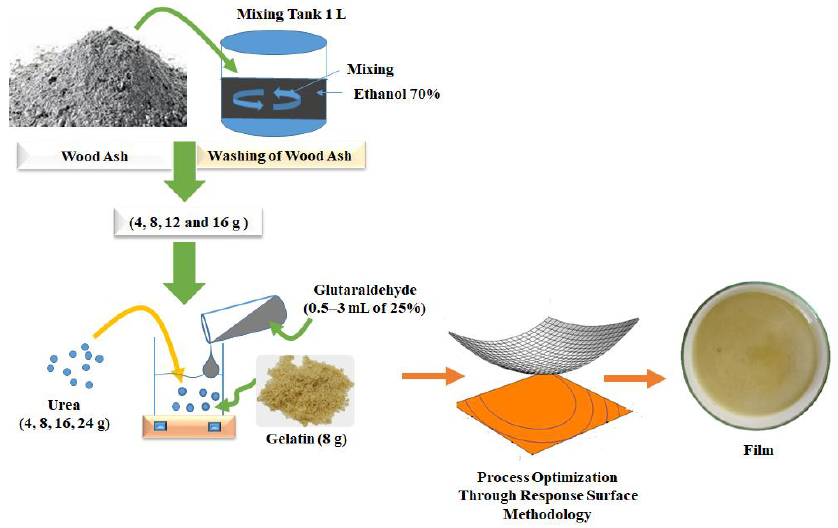
Figure 1. Gelatin film with urea modified by wood ash is being prepared as a slow-release fertilizer.